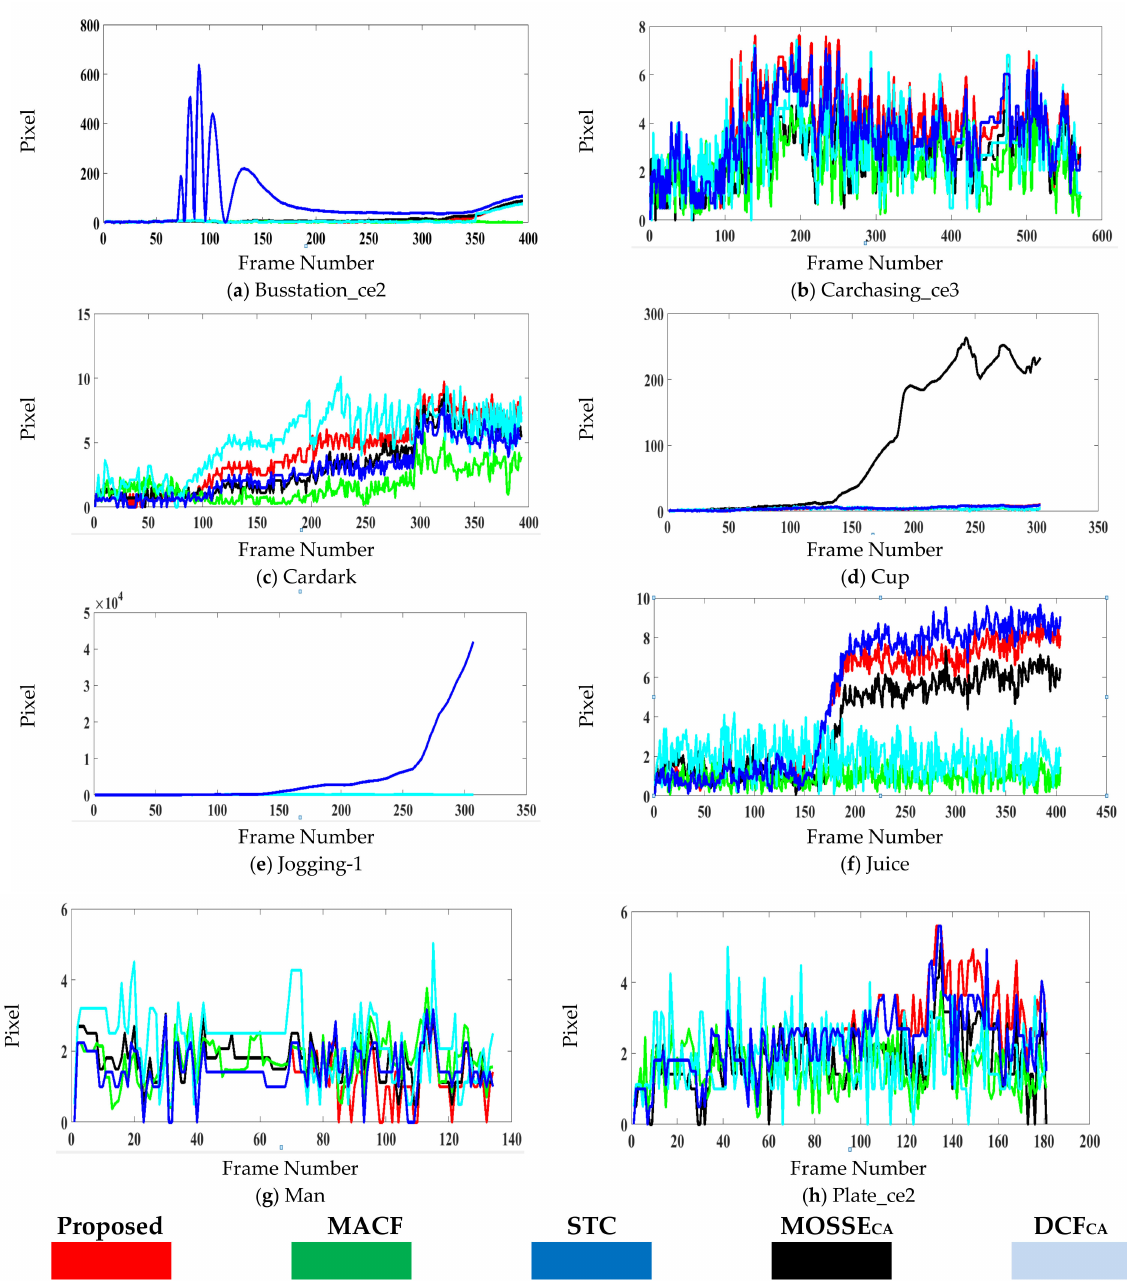
Figure 4. Centre location error (in pixels) comparison of proposed and other state-of-the-art trackers on selected image sequences taken from TC-128, OTB2013 and OTB2015